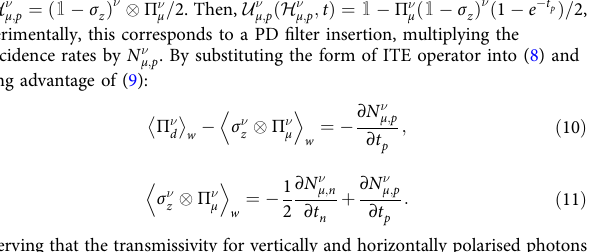
Fig. 2d. A pair of BDs, together with two HWPs separate and reconverges the horizontally and vertically polarised wavefunction. An ND fi lter on the vertically polarised path fi lters a fraction of photons to mimic the change of t p